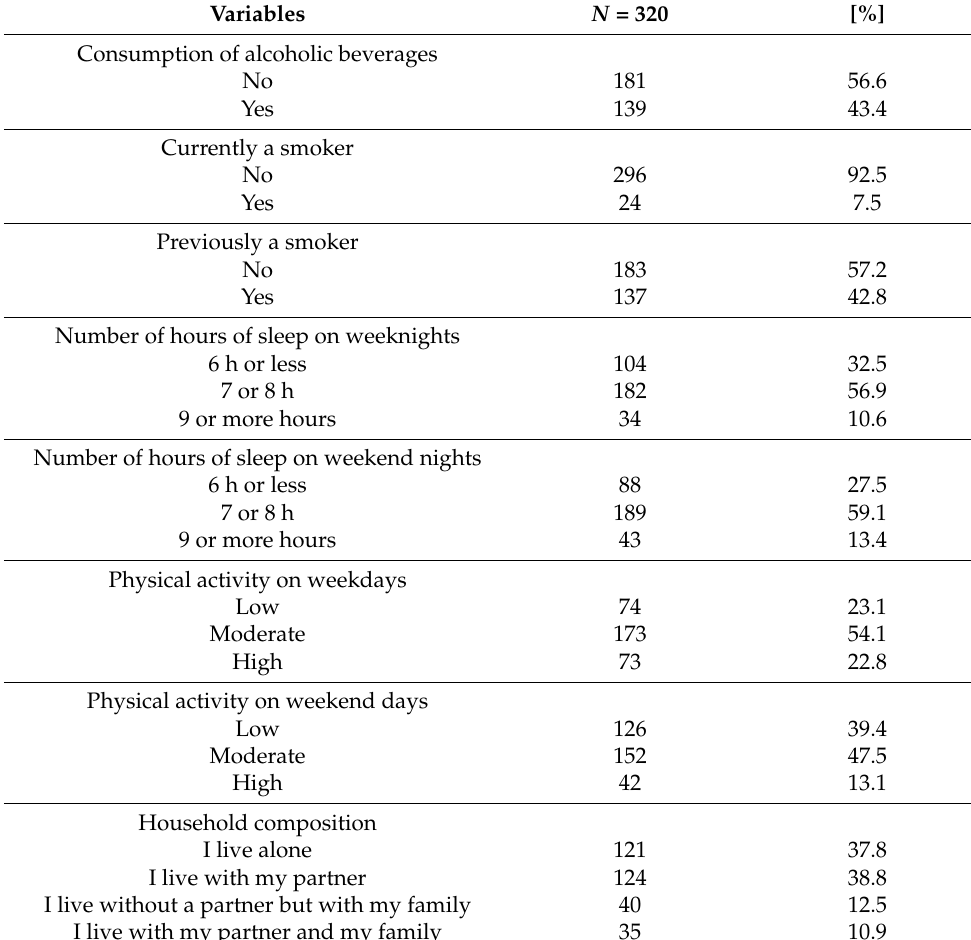
Table 3. Lifestyle characteristics of the